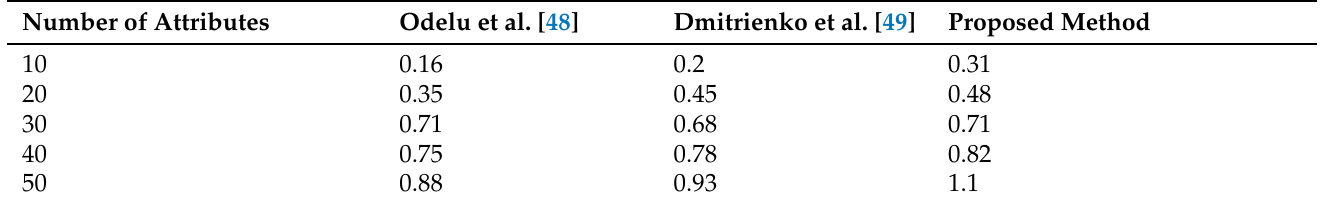
Table 7. Comparison of encoding time in IoT device.